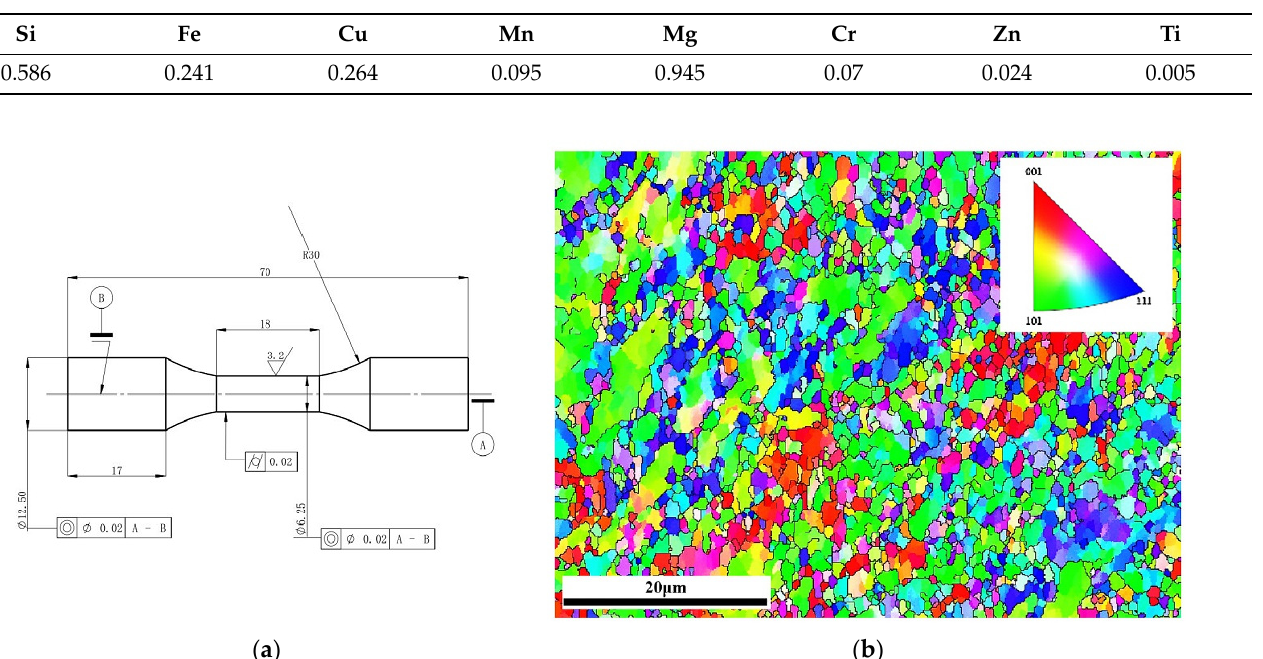
Table 1. Chemical composition of 6061 aluminum alloy (% in weight).